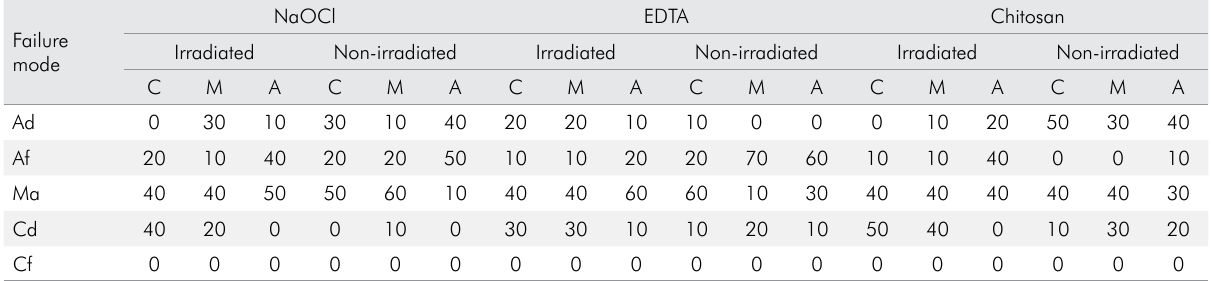
Table 4. Distribution of failure modes (%) after the push-out test for the different surface treatments at different root thirds in specimens subjected or not to radiation therapy.